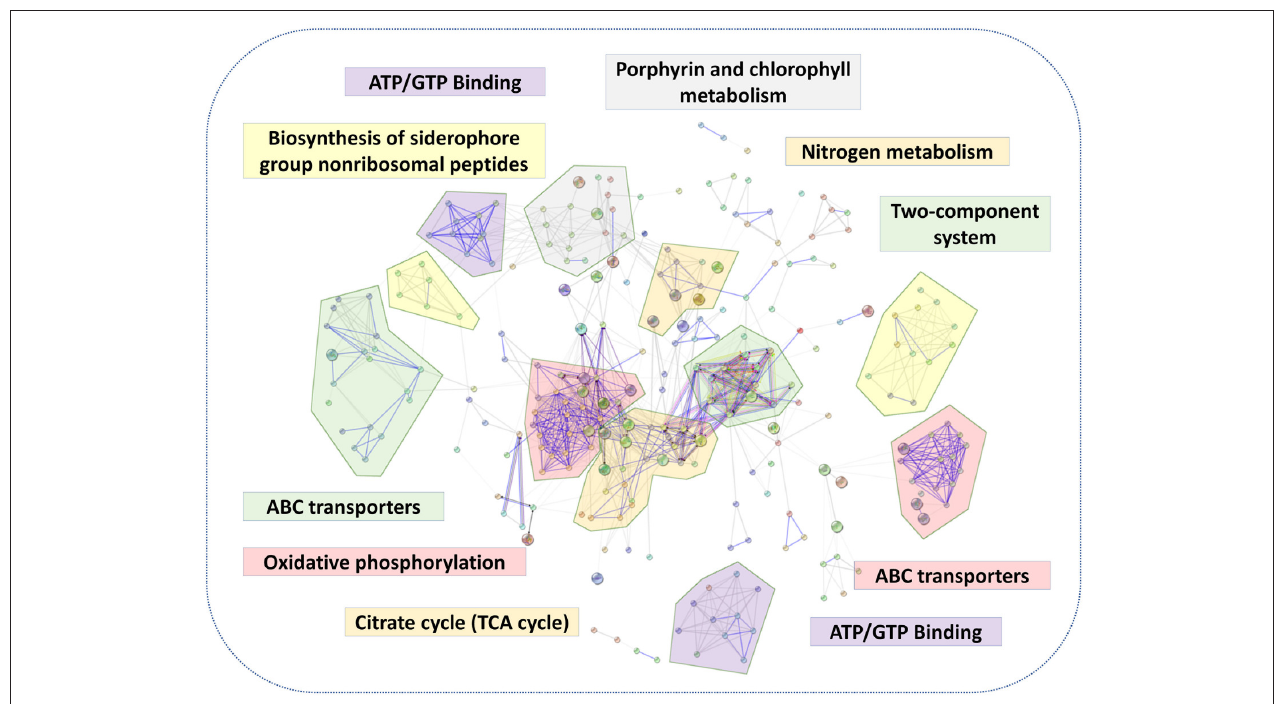
FIGURE 5 | The main metabolic changes of B. abortus in response to stress treatments. Possible interactions between DEPs under the stress treatments were tested using the STRING software tool. The network utilized 1st shell that contained 442 nodes and 1,904 edges with confidence score (0.7). KEGG pathway analyses of DEPs indicated major metabolic adaptation mechanisms of B. abortus in response to multiple environmental